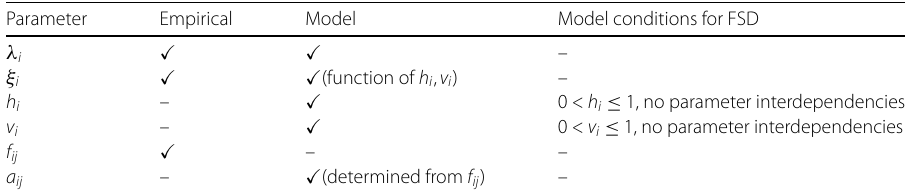
Table 1 Parameters that are either used directly as inputs in our model, Eqs. (5) and (6), or used to determine or postulate those input parameters. The firm-size distribution (FSD) emerges for the conditions stated in the table, particularly that there are no interdependencies among the parameters for a node (one particularly problematic one would be that h i and/or k i were correlated, but our results do not support this) Parameter Empirical Model Model conditions for FSD